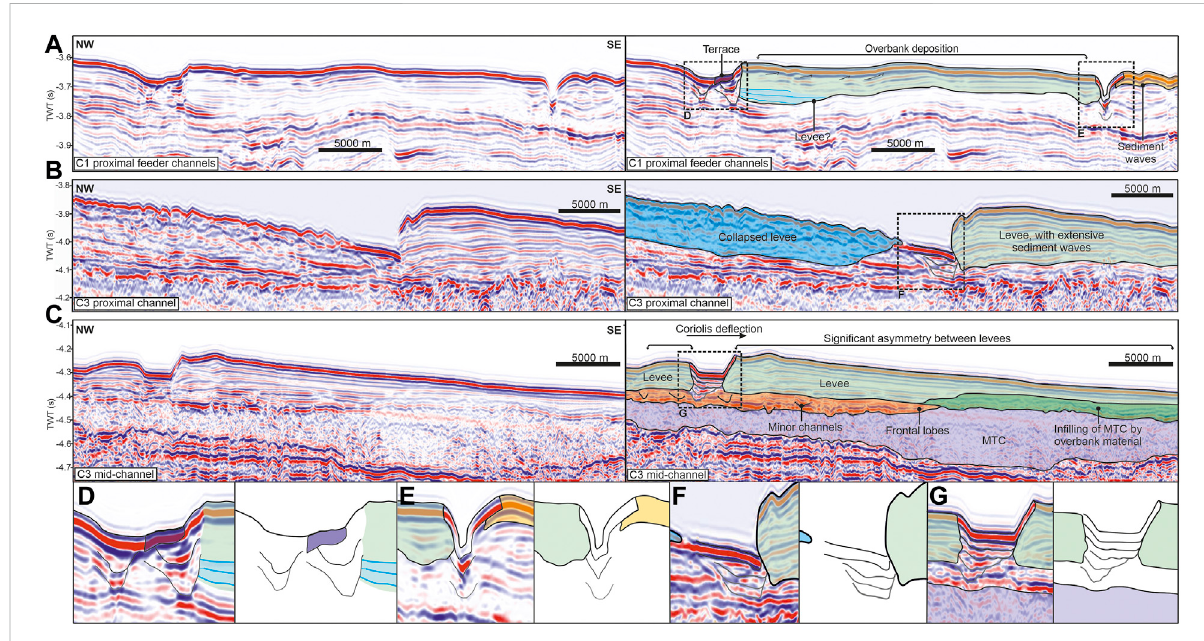
FIGURE 7 (A,B) Interpretedseismiccross-sections(locationsshowninFigure2A)fromdifferentchannellocations,withverticalchannelstackingoutlined, and shown in (D – G) . Signi fi cant levee asymmetry is also evident in (C) , with the levee reaching ~40 km in width.